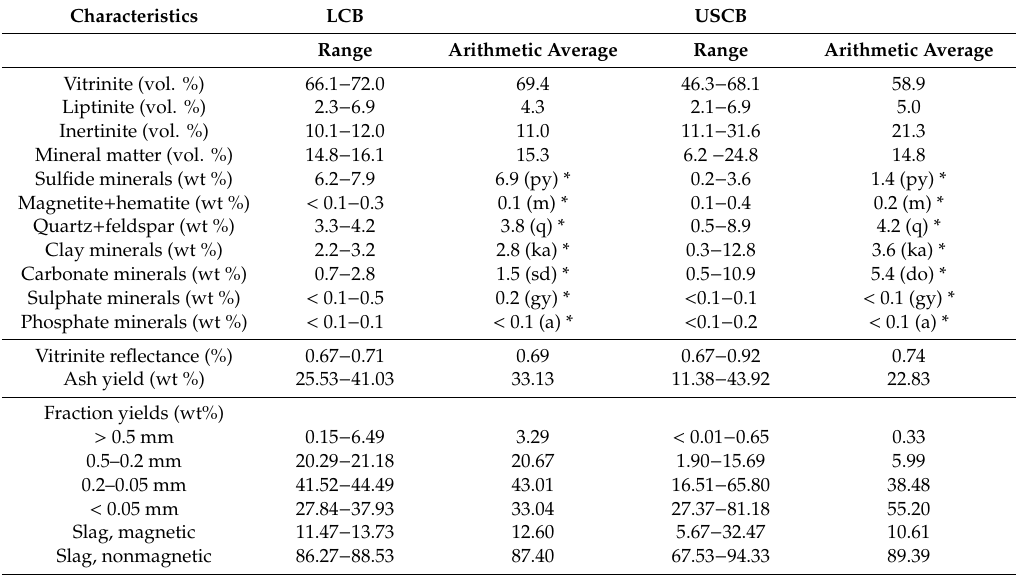
Table 1. Petrographic characteristics, vitrinite reflectance, and ash yield of feed coals from the LCB and USCB, and fraction yields of the fly ash and